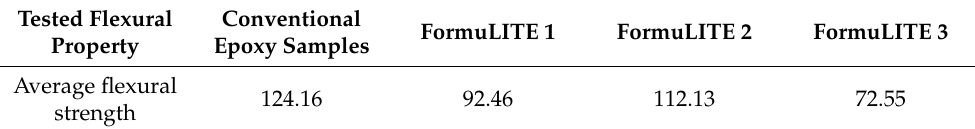
Table 3. Flexural strength of conventional epoxy and bio-based epoxy samples.